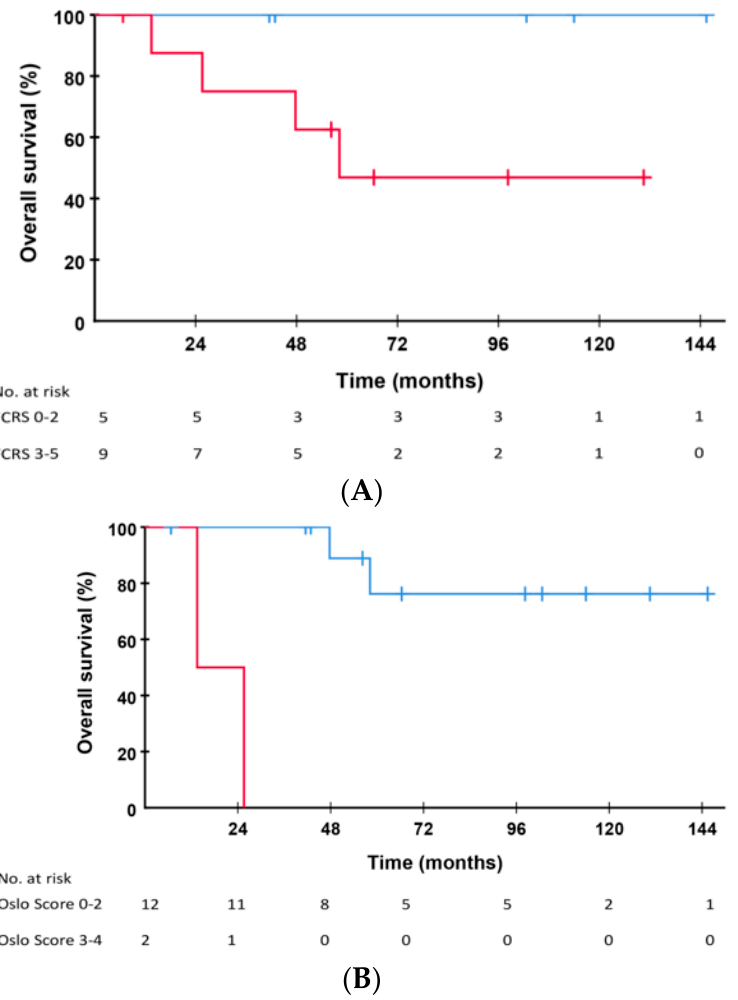
Figure 3. ( A ) Overall survival from time of pulmonary resection in patients with Fong Clinical Risk Score of 0–2 ( n = 5, blue line) versus FCRS of 3–5 ( n = 9, red line, p = 0.108). ( B ) Overall survival from time of pulmonary resection in patients with Oslo Score of 0–2 ( n = 12, blue line) versus Oslo Score of 3–4 ( n = 2, red line, p <